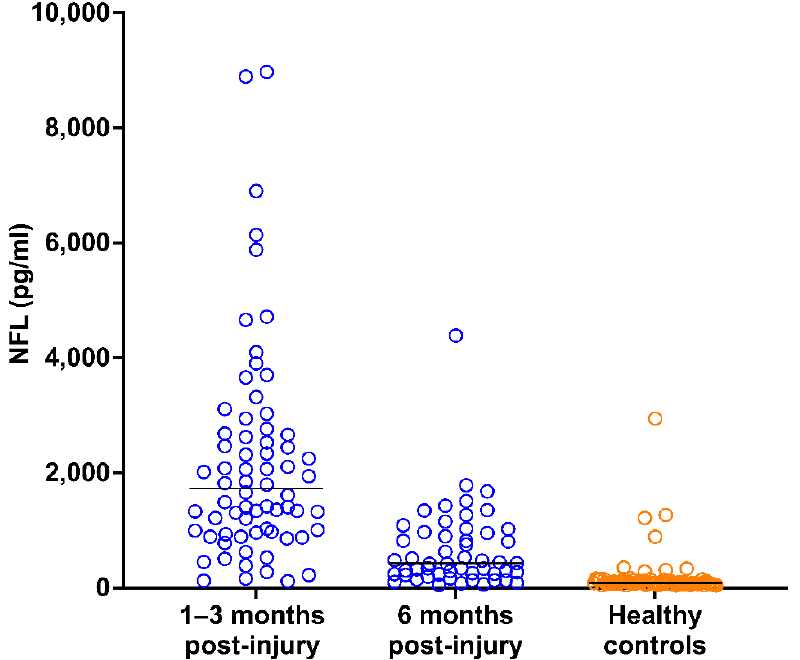
Figure 1. Study flow and patients’ levels of consciousness at 1–3 and 6 months post-injury. UWS, unresponsive wakeful- ness syndrome; MCS, minimally conscious state; E-MCS, emergence from a minimally conscious state; NFL, neurofilament light chain.